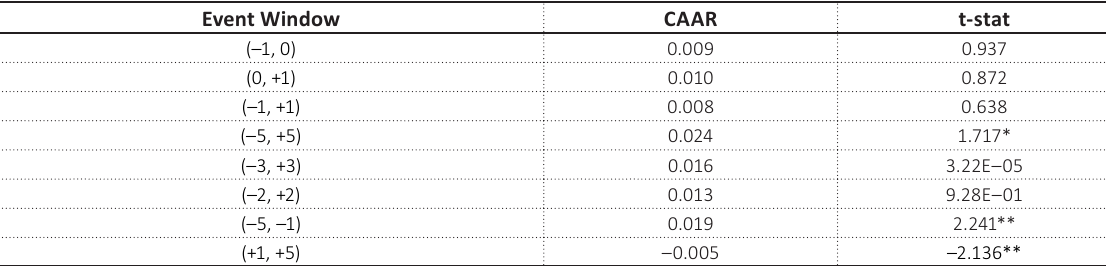
Table 3. CAAR for different event windows for shorter duration Event Window